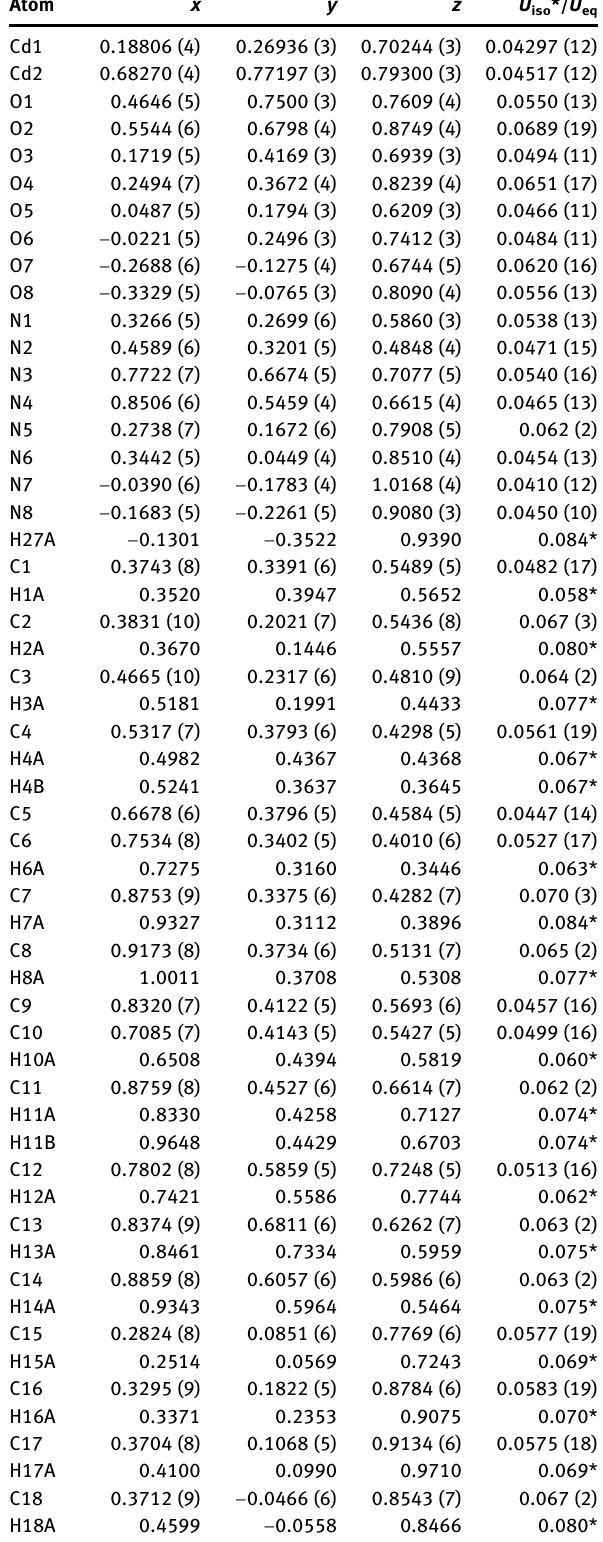
Table  : Fractional atomic coordinates and isotropic or equivalent isotropic displacement parameters (Å 